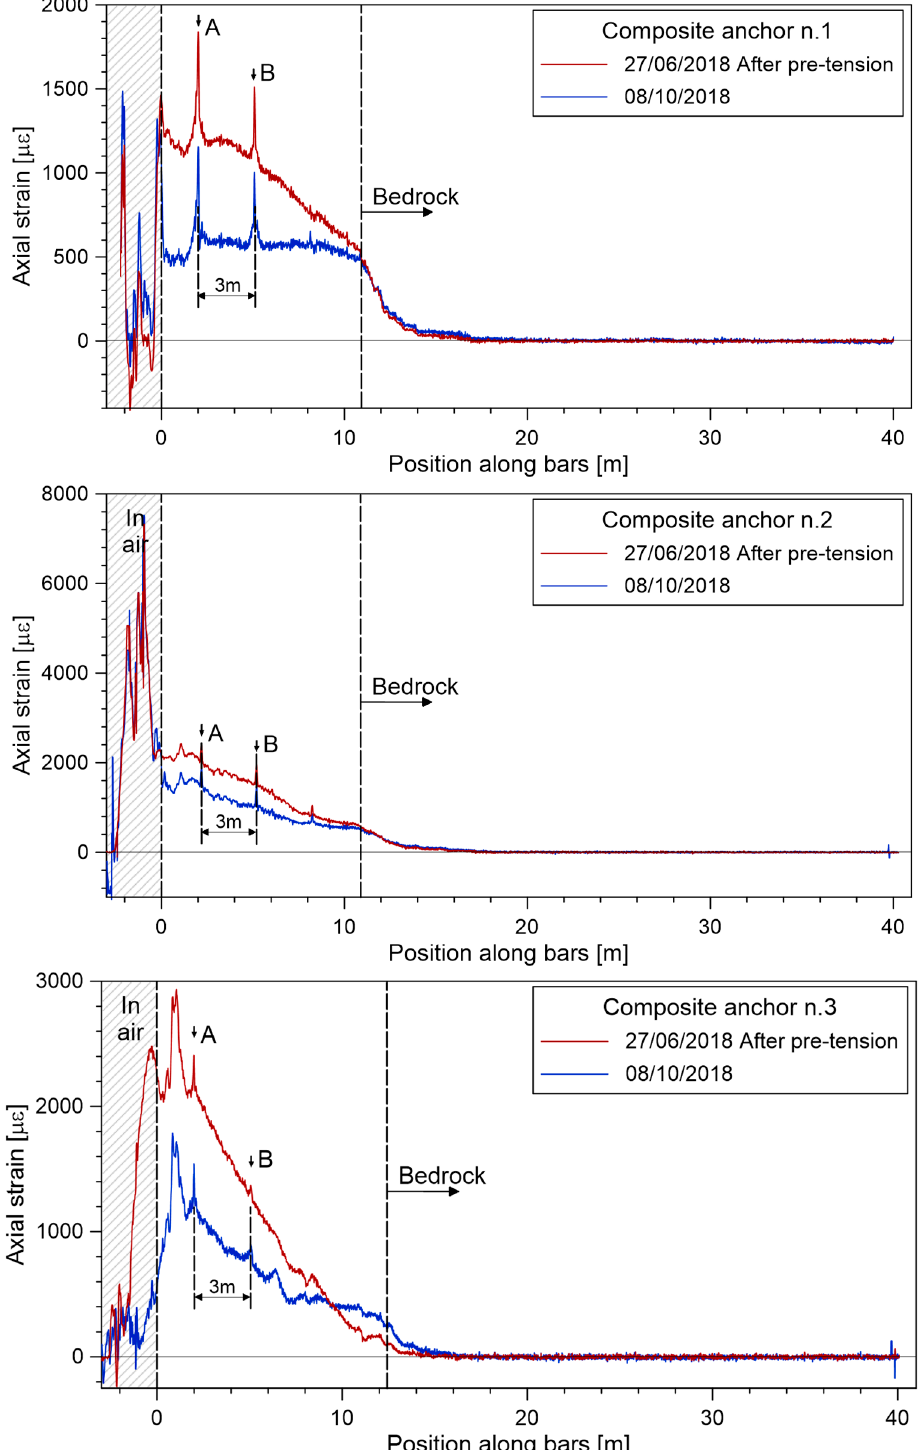
Figure 14. Axial strain along anchors immediately after pre-tension and after about 3 months of the three tested composite anchors.